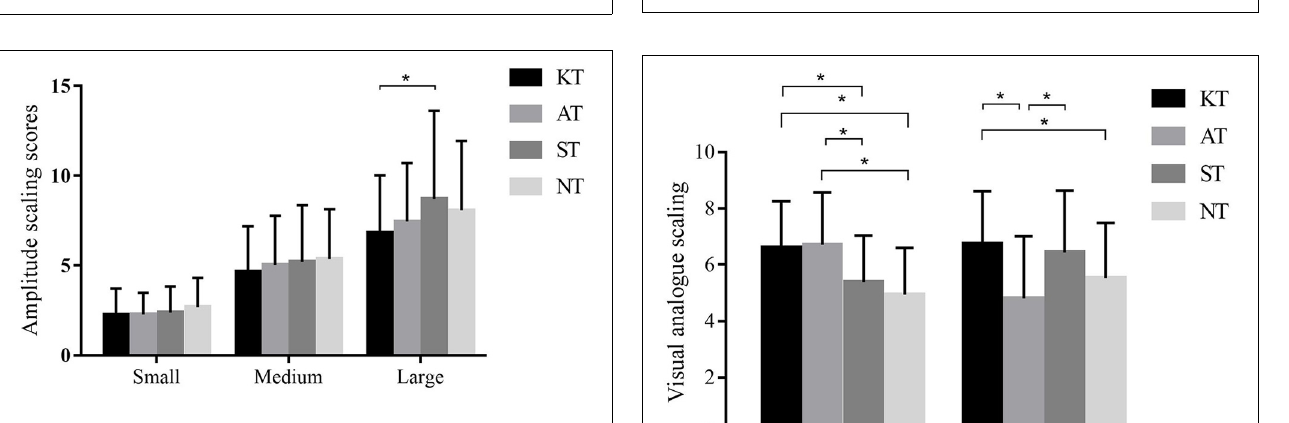
FIGURE 3 | Amplitude scaling scores of four different taping treatments in backward slips in MCT. * p < 0.05.